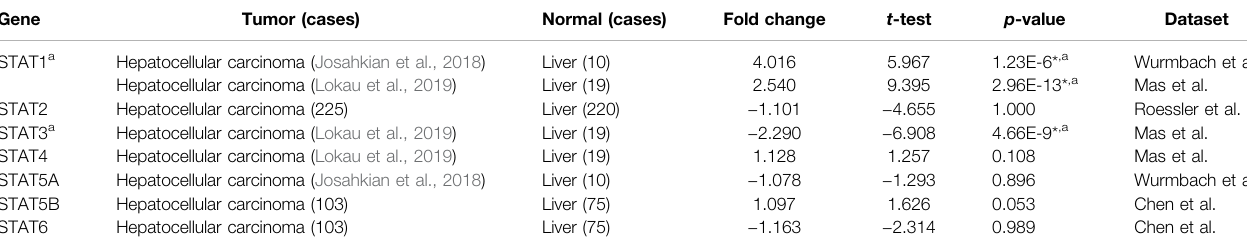
TABLE 1 | Datasets of the STAT family in hepatocellular carcinoma (Oncomine).